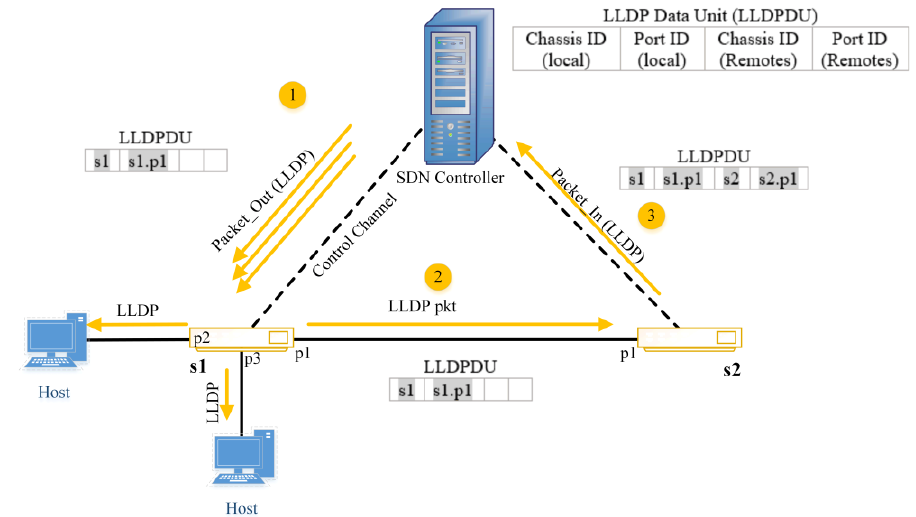
Figure 6. OFDP protocol methodology [39].